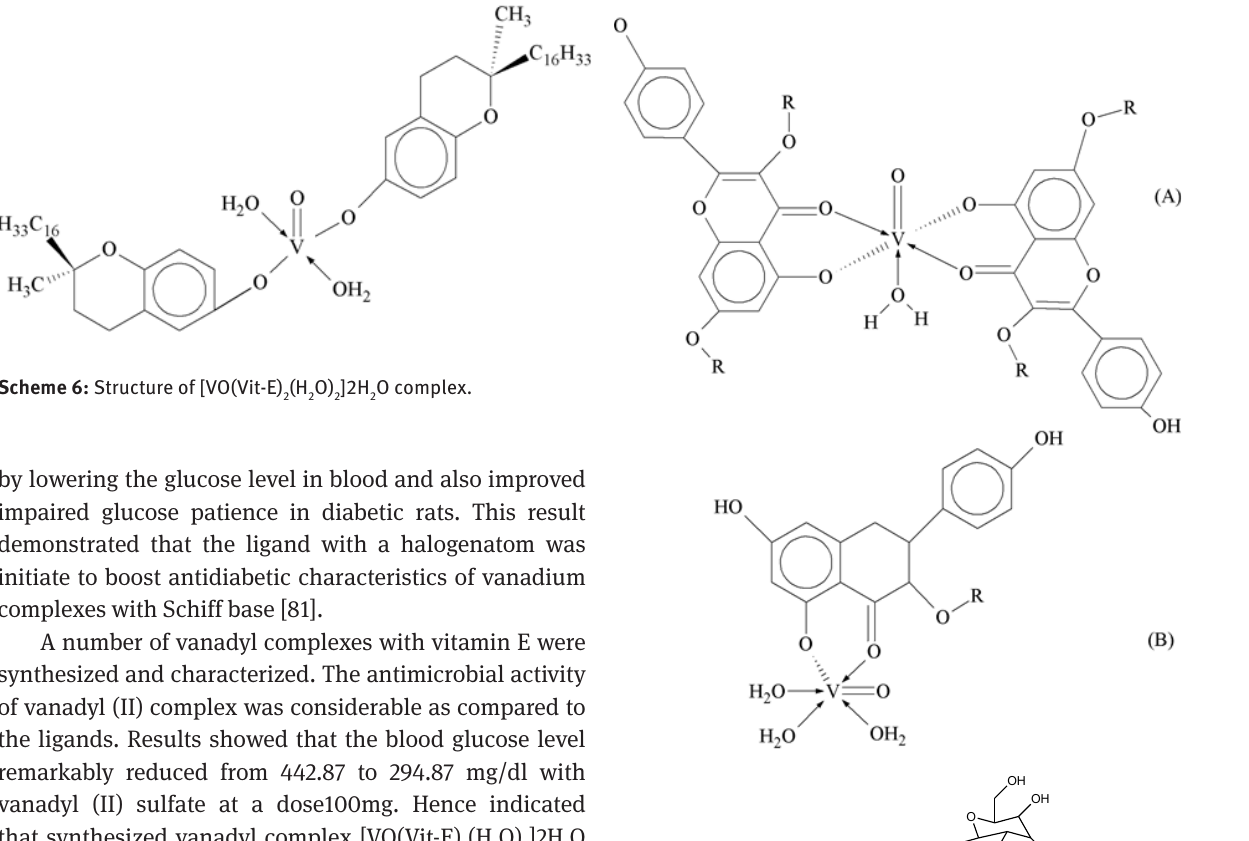
OHOH Scheme 7: Glycosylated flavonoids complexes (A) = M: L (1:2) & (B) = M: L (1:1). Scheme 7: Glycosylated flavonoids complexes (A) = M: L (1:2) & (B) In 2005, Xie along his co-workers synthesized a potent oral active bis- (α - = M: L furancarboxylato)oxovanadium (IV) complex used for treatment of diabetes mellitus in experimental animals. The complex showed antidiabetic activity by normalizing the glucose and lipids values without any effect on insulin level after 4-week treatment. The results